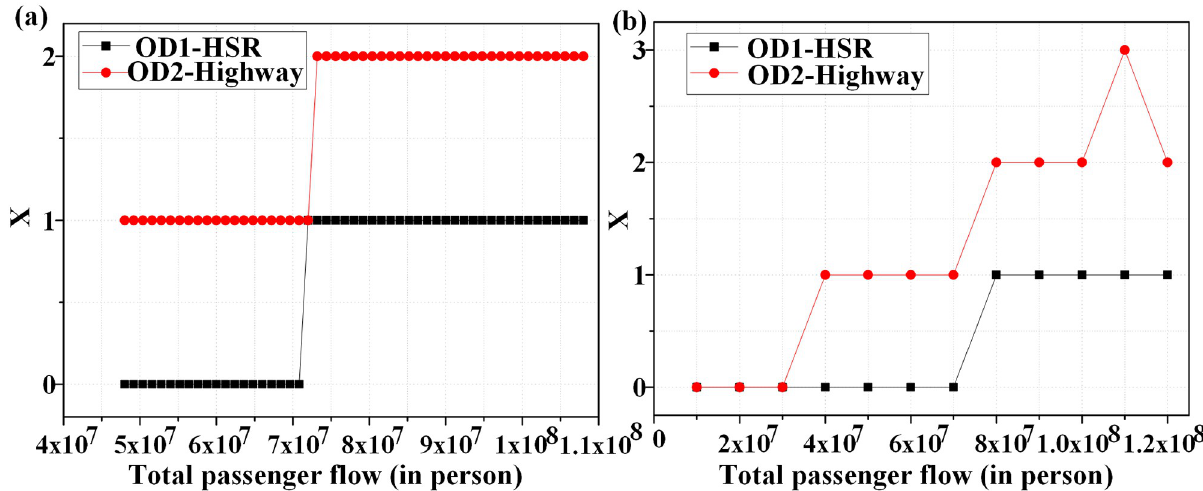
Fig 3. Influence of demand on corridor configuration (a) Distribution A; (b) Distribution B.